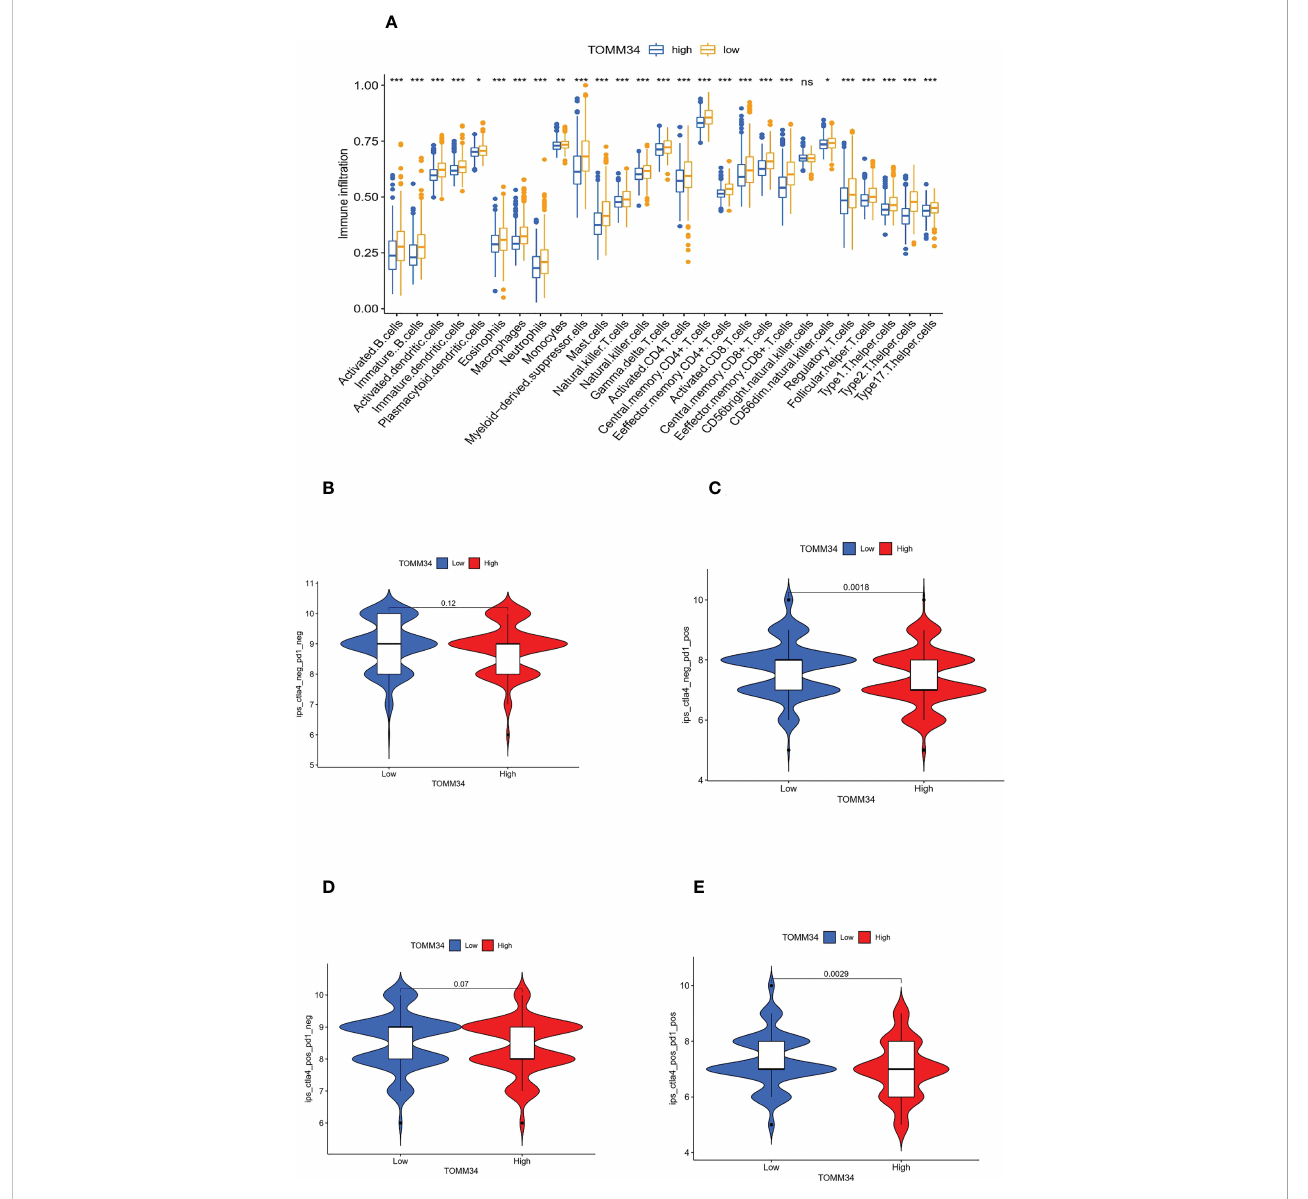
FIGURE 6 Correlation between TOMM34 expression and immune cell in fi ltration level. (A) Immune cell in fi ltration levels in distinct TOMM34 groups, showing that 26 types of immune cells except CD56 bright natural killer cells were elevated in the low TOMM34 group compared with the high TOMM34 group. (B-E) Violin plot of IPS among ips_ctla4_neg_pd1_neg (CTLA-4 negative response and PD-1 negative response), ips_ctla4_neg_pd1_pos (CTLA-4 negative response and PD-1 positive response), ips_ctla4_pos_pd1_neg and ips_ctla4_pos_pd1_pos in the respective TOMM34 groups, showing that patients in the low TOMM34 group displayed signi fi cant clinical advantages for anti-PD-1 immunotherapy. ***p<0.001, **0.001 ≤ p<0.01, *0.01 ≤ p<0.05, ns,